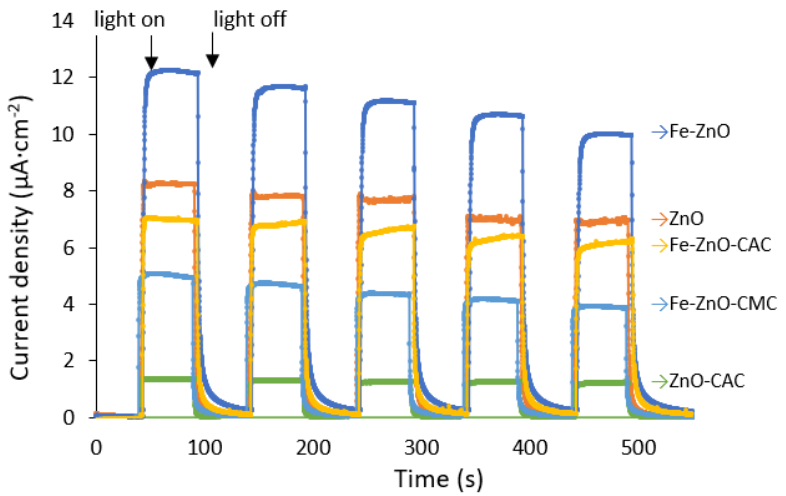
Figure 7. Transient photocurrent response of photocatalysts from 0.5%Fe-ZnO- 40%CAC series (λ = 380 – 390 nm, [Na 2 SO 4 ] = 1 M).